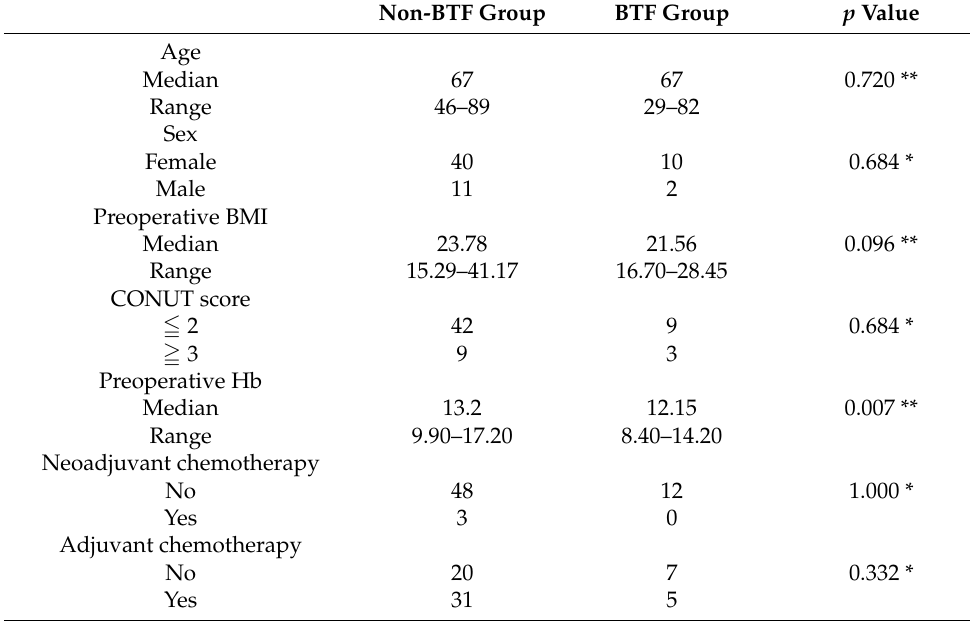
Table 1. Patient characteristics.